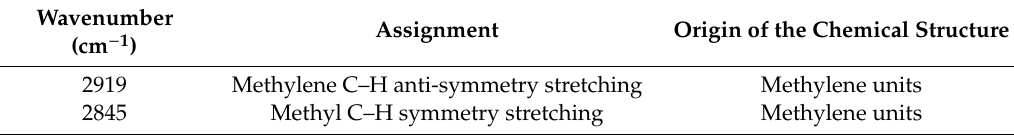
Figure 3. FTIR spectra for pure asphalt binder and the three samples. Table 4. Peaks and assignments for the FTIR wavenumber range 2750–3000 cm − 1